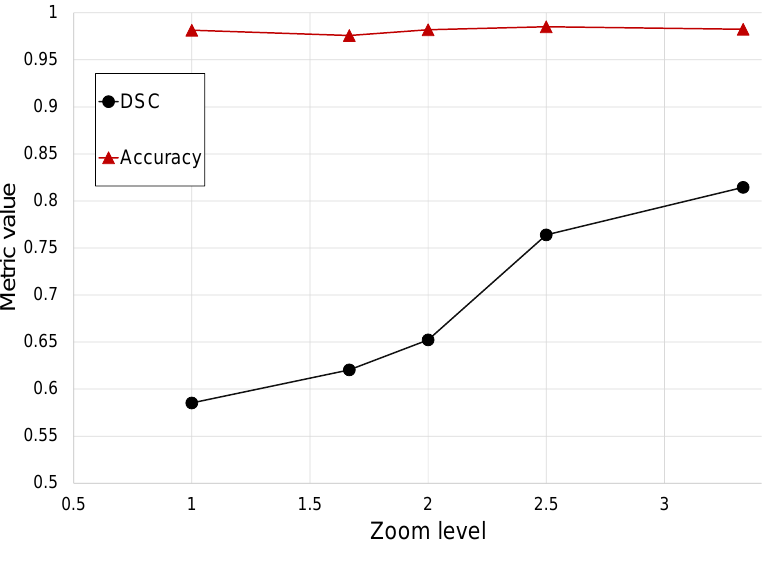
Figure 14. DSC and Accuracy metrics as a function of the zoom